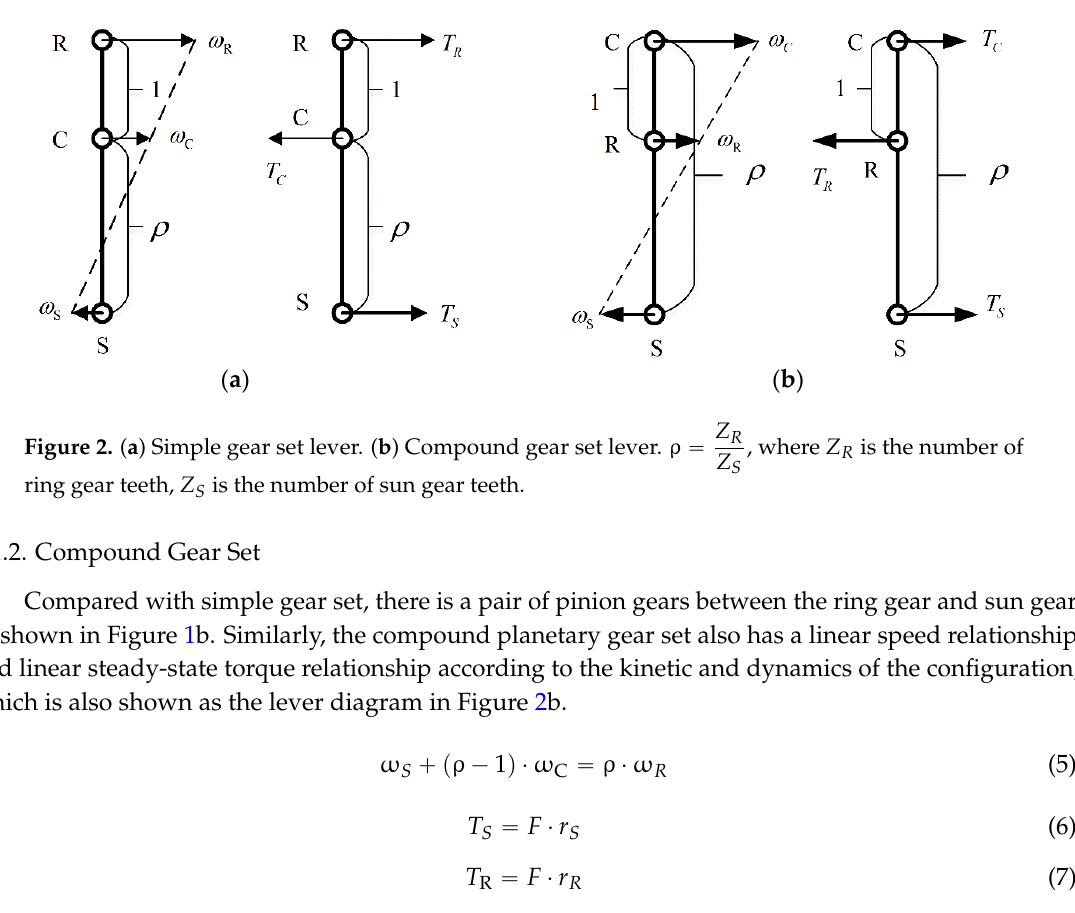
Figure 1. ( a ) Simple gear set scheme; and ( b ) compound gear set scheme.